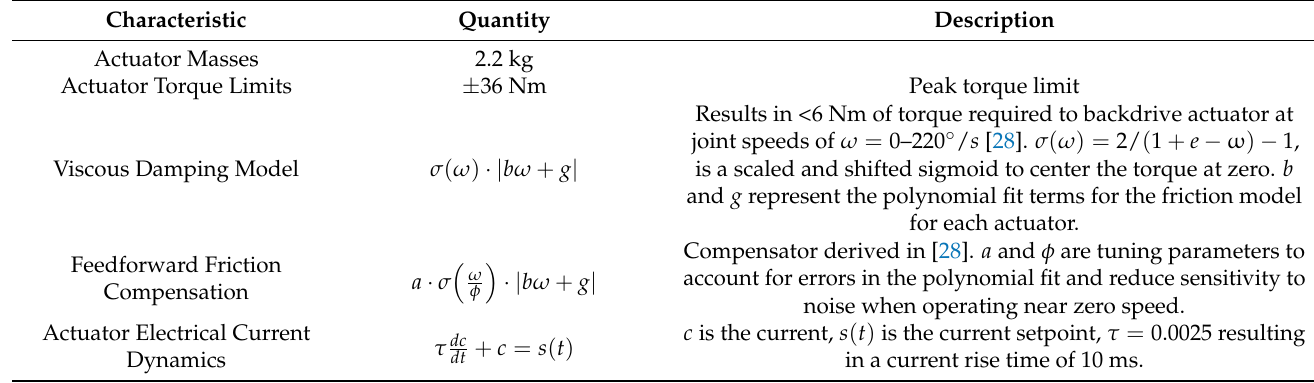
Table 1. Simulated MAHNP